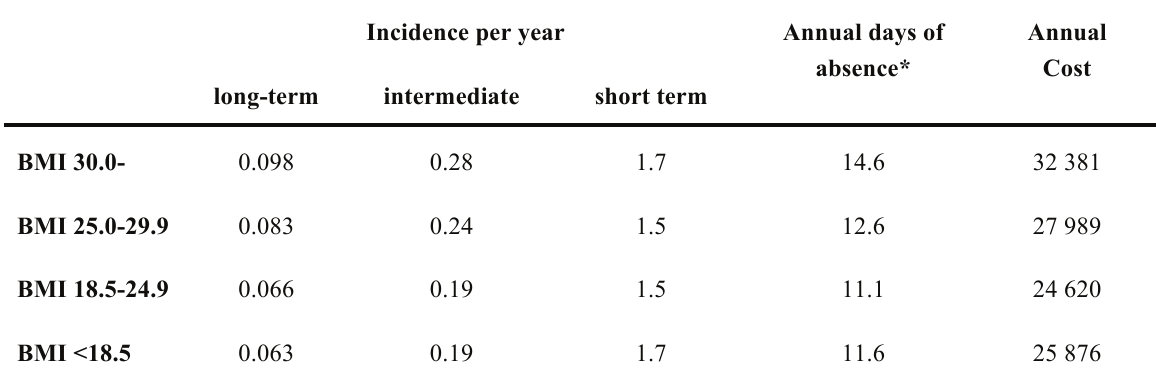
Annual indirect costs of sick-leave (Year 2012 SEK), stratified by BMI in young adolescence (derived from Neovius et al